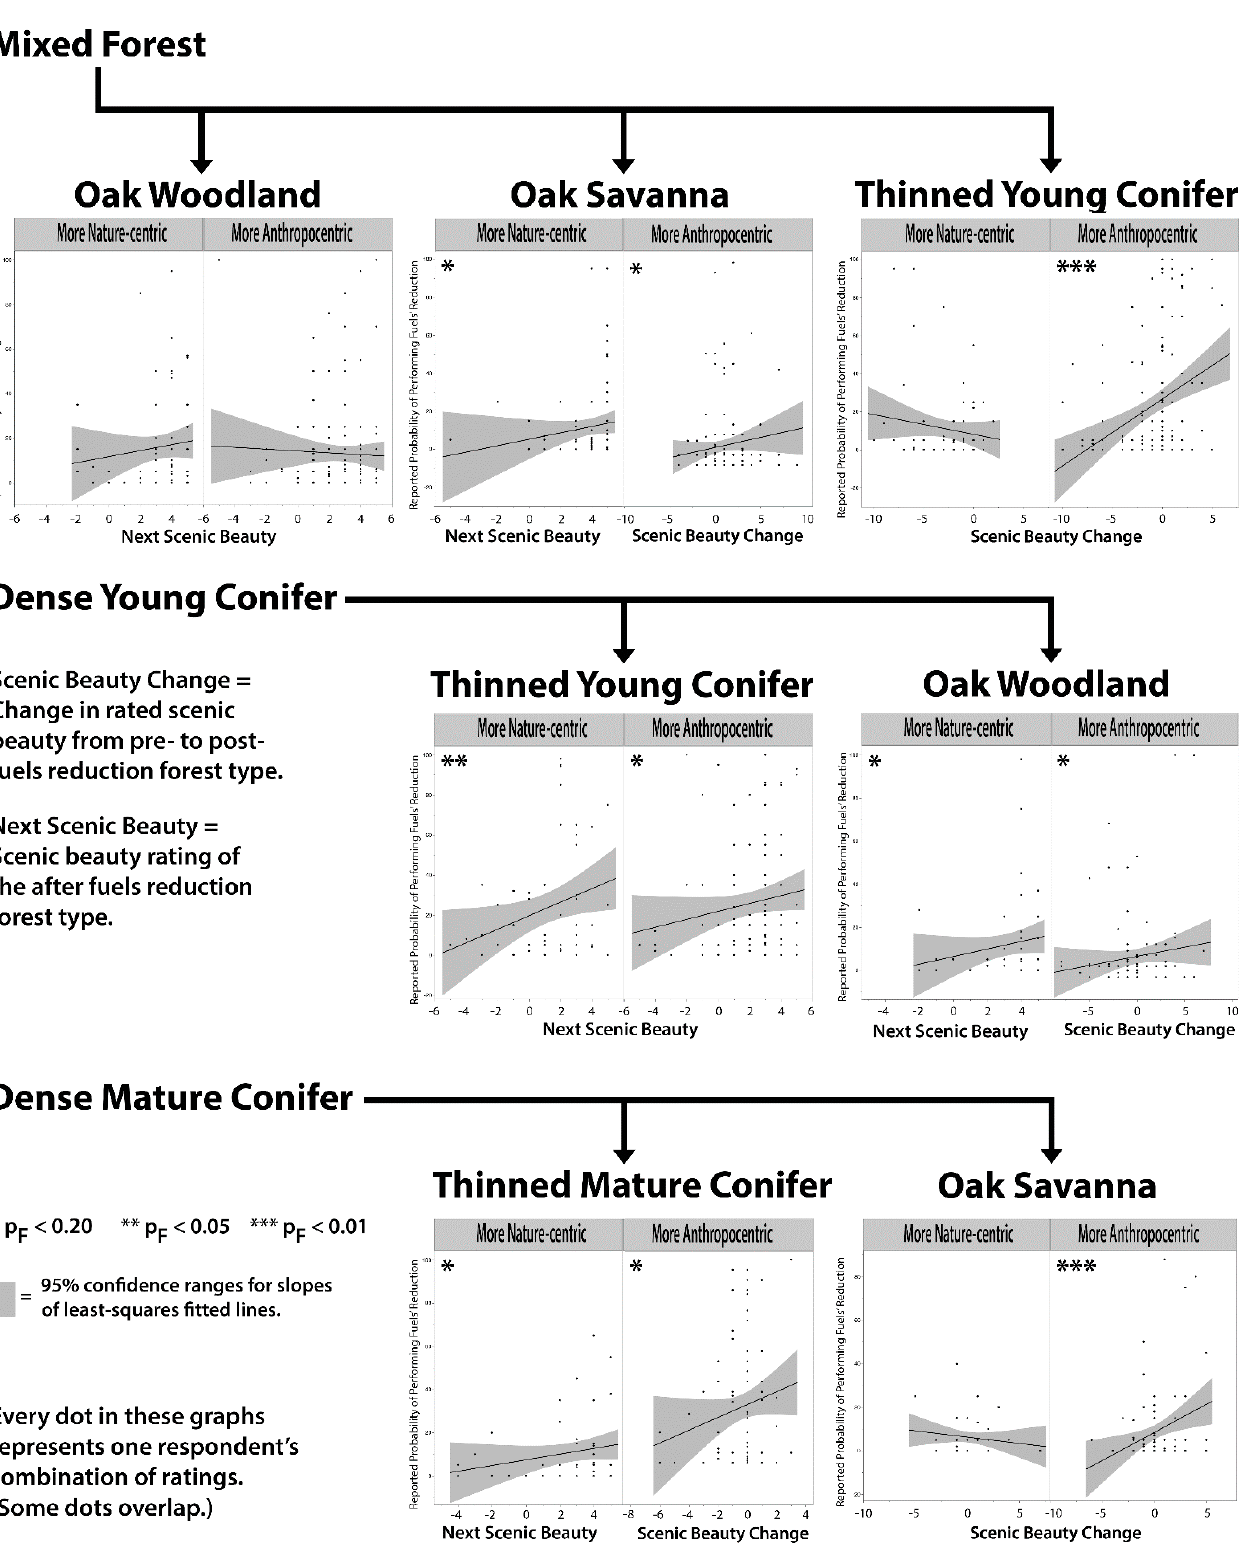
Figure 14. Attitudes toward nature and land management in relation to how scenic beauty perceptions correlate to fuels reduction propensities across all seven project types.